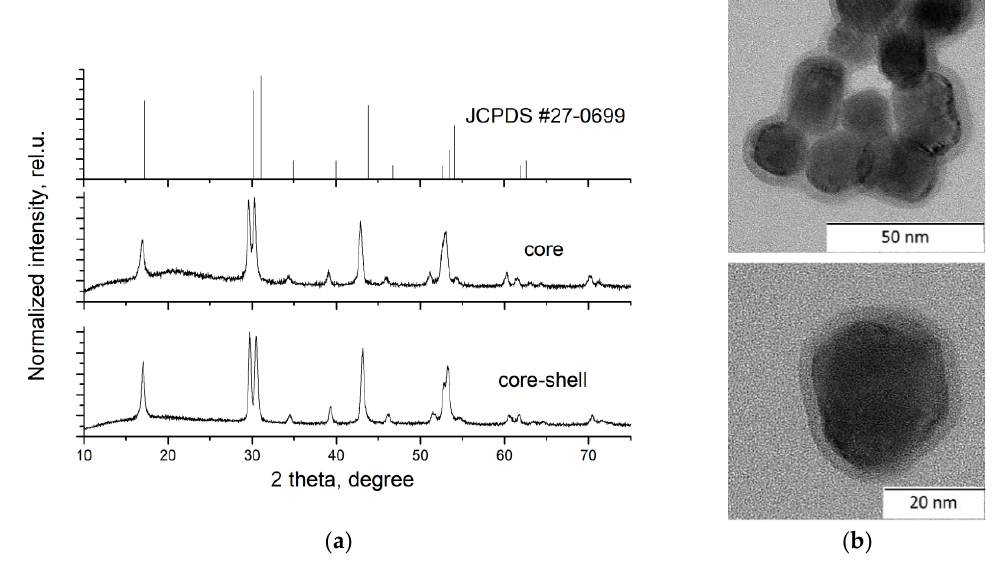
Figure 1. ( a ) XRD diagrams of JCPDS #27-0699 and NaGdF 4 :Yb 3+ , Ho 3+ , Er 3+ core and core-shell